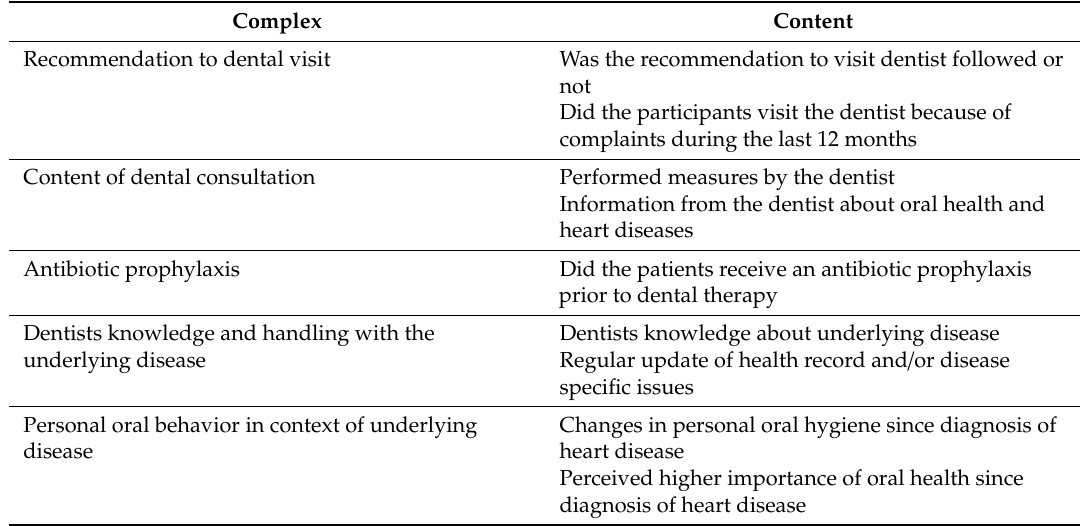
Table 1. Complexes of applied questionnaire and related content at the follow-up